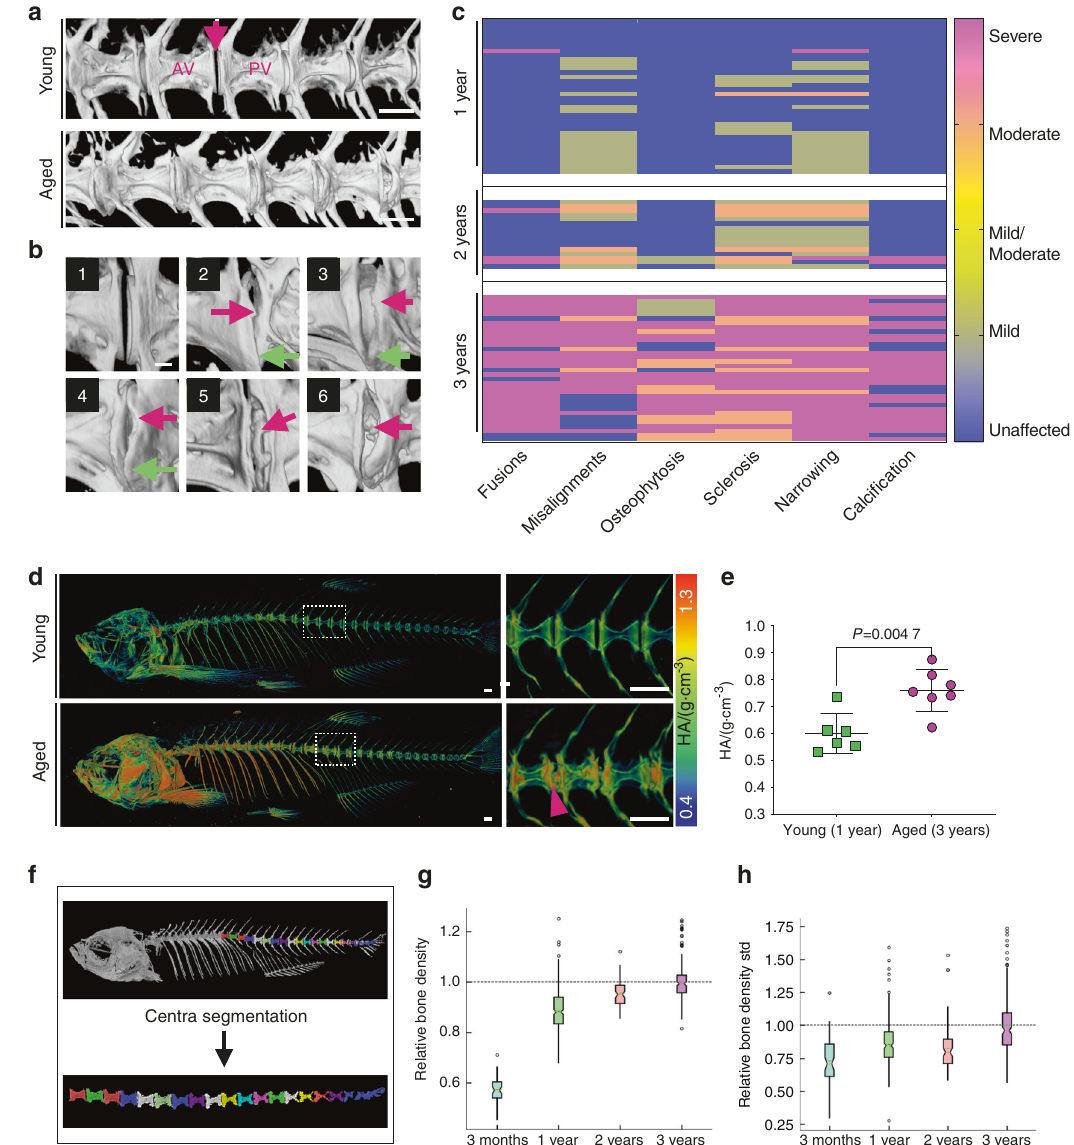
Fig. 1 Progressive abnormalities found in aged zebra fi sh vertebral columns. a 3D rendering from μ CT images of young (1 year) and aged (3 years) spines. AV anterior vertebra, PV posterior vertebra, IVD (arrow). Scale bar = 500 μ m. b Frequent changes observed at the IVD. 1: normal IVD; 2: osteophytes (pink arrow), vertebral misalignment and IVD narrowing (green arrow); 3: endplate sclerosis; 4: sclerosis (pink arrow) and IVD narrowing (green arrow); 5: sclerosis and fusion (pink arrow); 6: sclerosis and IVD calci fi cation (pink arrow). Scale bar = 100 μ m. c Heat map graph showing spinal morphological changes classi fi ed by severity during aging (1 year n = 36 (42% females, 58% males), 2 years n = 16 (57% females, 43% males), and 3 years n = 34 (55% females, 45% males)). Average fi sh standard lengths (measured from tip of the head to the last vertebral column): 1 year = 3.22 cm (0.19 SD), 2 years = 3.41 cm (0.18 SD), and 3 years = 3.46 cm (0.23 SD). d 3D rendering from μ CT images of young and aged fi sh, color coded to show bone mineral density changes. The selected area of the spine (dashed box) is magni fi ed, as shown on the right of the panel. Higher density colocalizes with regions of sclerosis and deformities (arrowhead) in the aged spine. Scale bar = 500 μ m. e TMD (tissue mineral density) retrieved from the third thoracic vertebrae in young (1 year) and aged (3 years) fi sh. Nonparametric, two-tailed, Mann – Whitney test; data are the mean and SD. P values are indicated. f 3D volume rendering from a μ CT image of wt fi sh showing an individual vertebral centrum segmented by computational automation. g Relative bone density from the vertebral centra in aging fi sh (3 months to 3 years). Average standard lengths: 3 months = 2.6 cm (0.18 SD); 3 years = 3.46 cm (0.23 SD). The notch plot was scaled by the average value from the 3-year centra. h Within-sample standard deviation in bone density. The notch plot was scaled by its average value from the 3-year centra. c , e Generated in Prism 8. g , h Graph was generated in we analyzed the vertebral column and IVD of young fi sh with Young zebra fi sh with low BMD show premature radiographic IVDD genotypes associated with reduced bone density. Sp7 is a major The study of aging zebra fi sh to disentangle the association osteogenesis transcription factor expressed in osteoblasts 44,45 . between BMD and IVDD is complex, as our data indicate increased BMD associated with IVDD in aging fi sh; furthermore, increased Genome-wide association studies (GWAS) have identi fi ed associa- fragility in aged bones, resembling osteoporosis, was also tions between SP7 and BMD 46 , between SP7 and lumbar spine associated with IVDD in aging zebra fi sh. To probe this relationship, BMD and between SP7 and estimated BMD (musculoskeletal